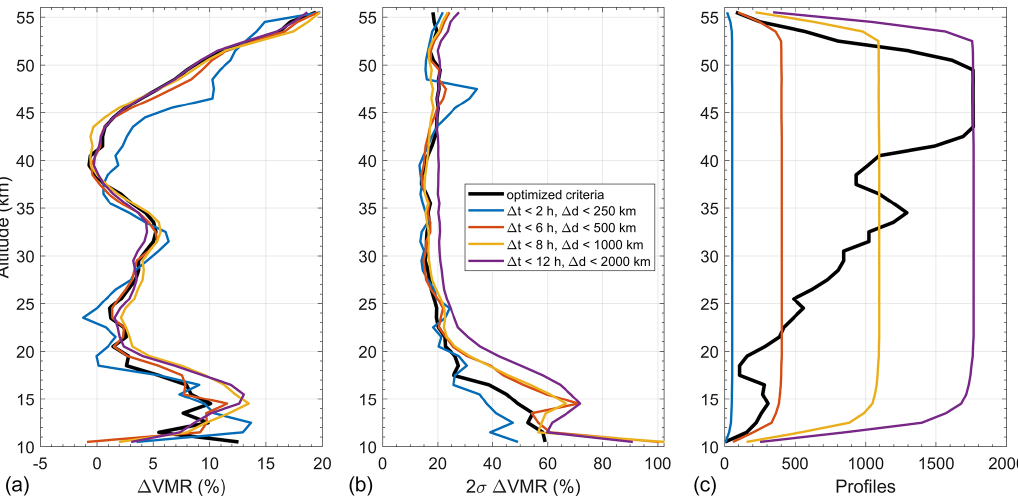
Figure 9. The bias (a) and 2 σ variability (b) of the relative differences between ACE-FTS and OSIRIS O 3 profiles in the southern polar region at different coincidence criteria, including the optimized criteria for 10% variability above 17km and 15% below 17km and the corresponding number of coincident profiles (c)